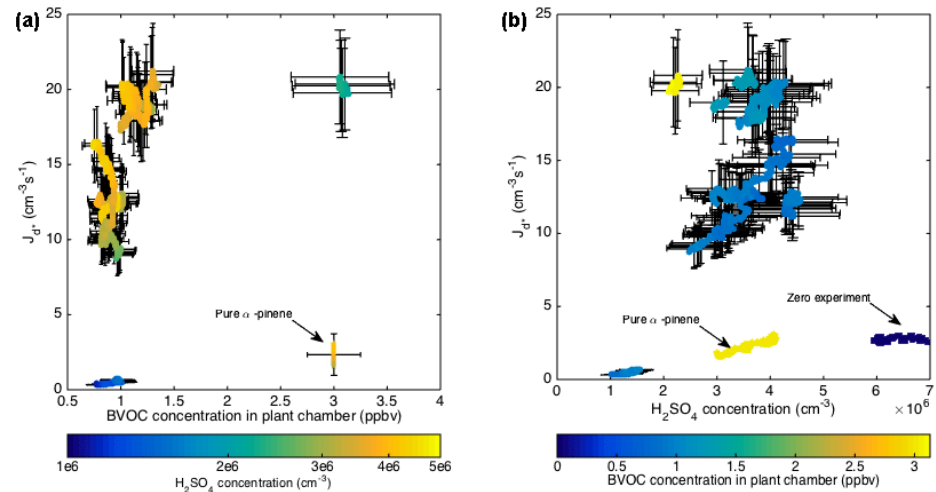
Figure 4. (a) Particle formation rates ( J ) as function of BVOC concentration, and marker colours indicate the corresponding H 2 SO 4 con- centrations in log scales. (b) Particle formation rates ( J ) as function of H 2 SO 4 concentrations. Marker colours indicate the corresponding BVOC concentration from the inlet flow. Square markers show data from alpha-pinene experiments; star markers show a zero experiment with no BVOC added.